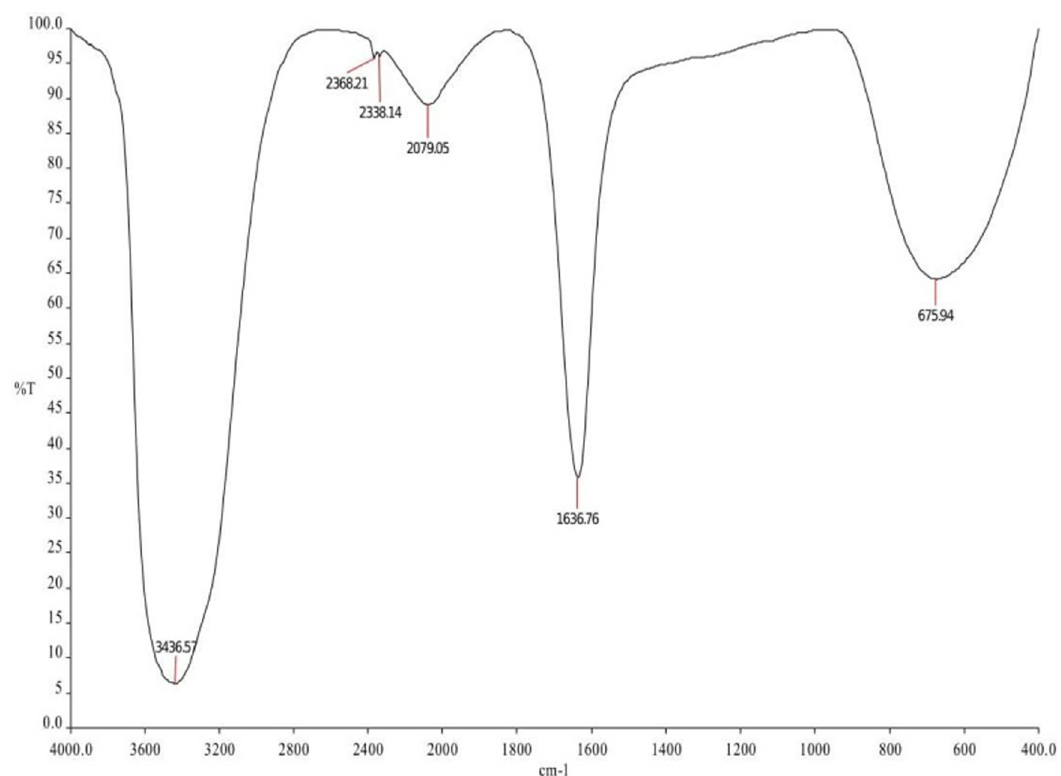
Figure 10: FTIR spectrum of methanolic extract of D. viscosa